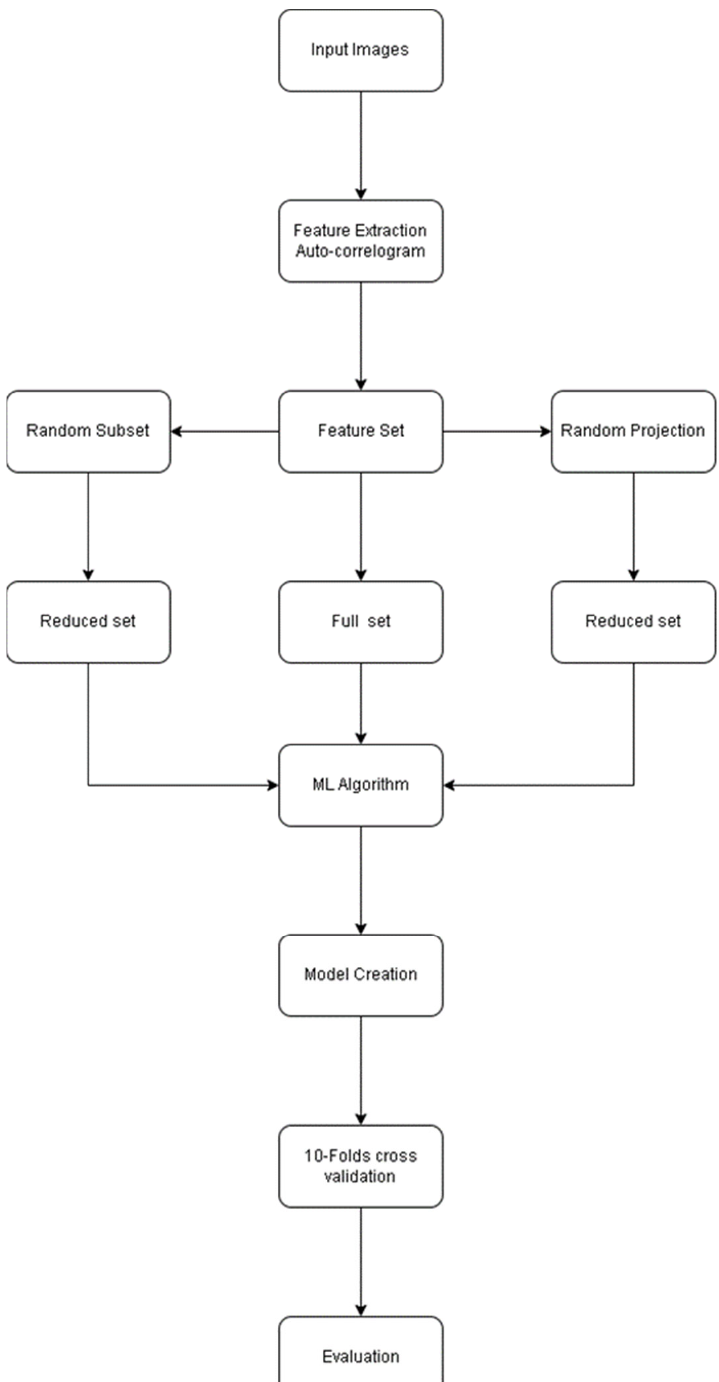
Figure 1. Proposed evaluation methodology.